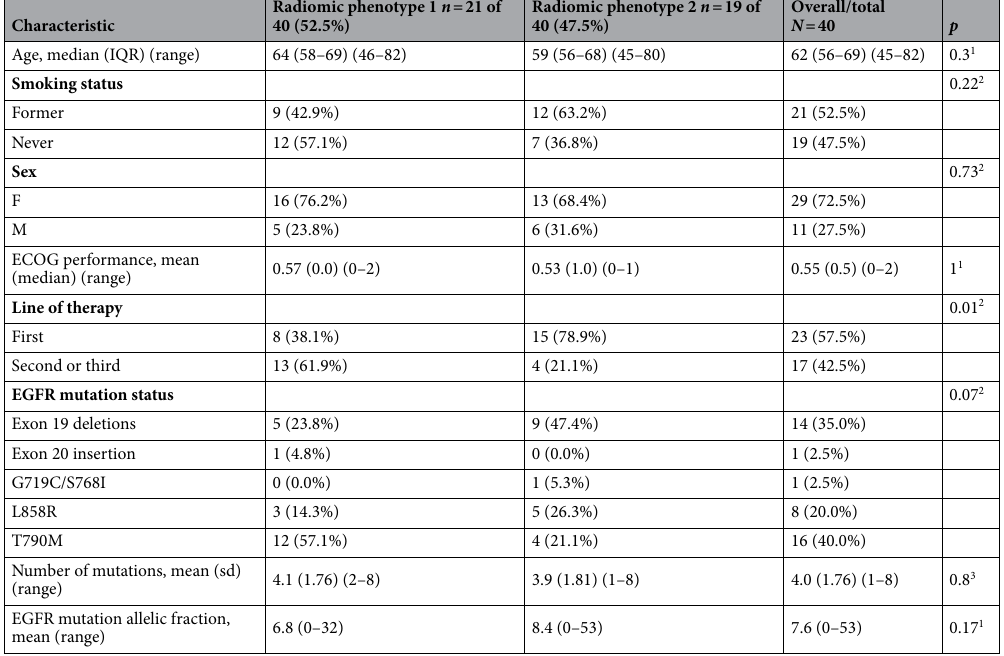
Table 1. Patient characteristics. 1 p value by Mann–Whitney–Wilcoxon test, two-sided. 2 p value by Fisher’s exact test, two-sided. 3 p value by Welch’s t-test,